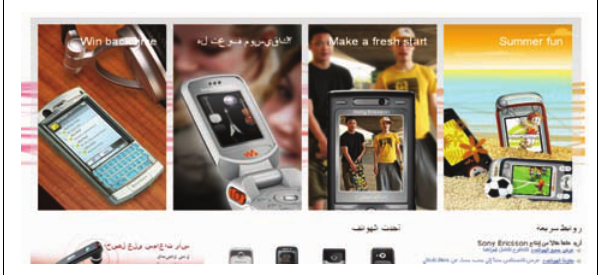
Fig 9. Sony Ericsson Egypt: Variety and fun 4